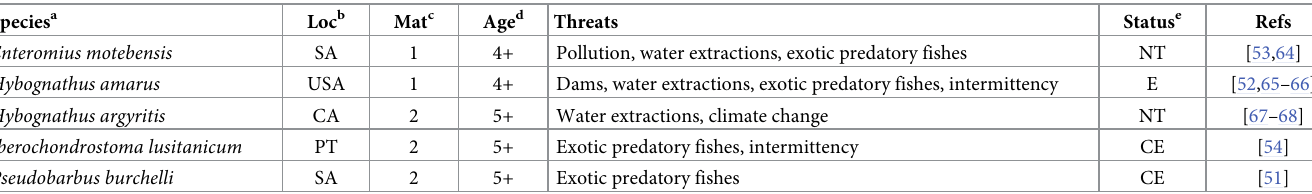
Table 1. A synopsis of study species and data